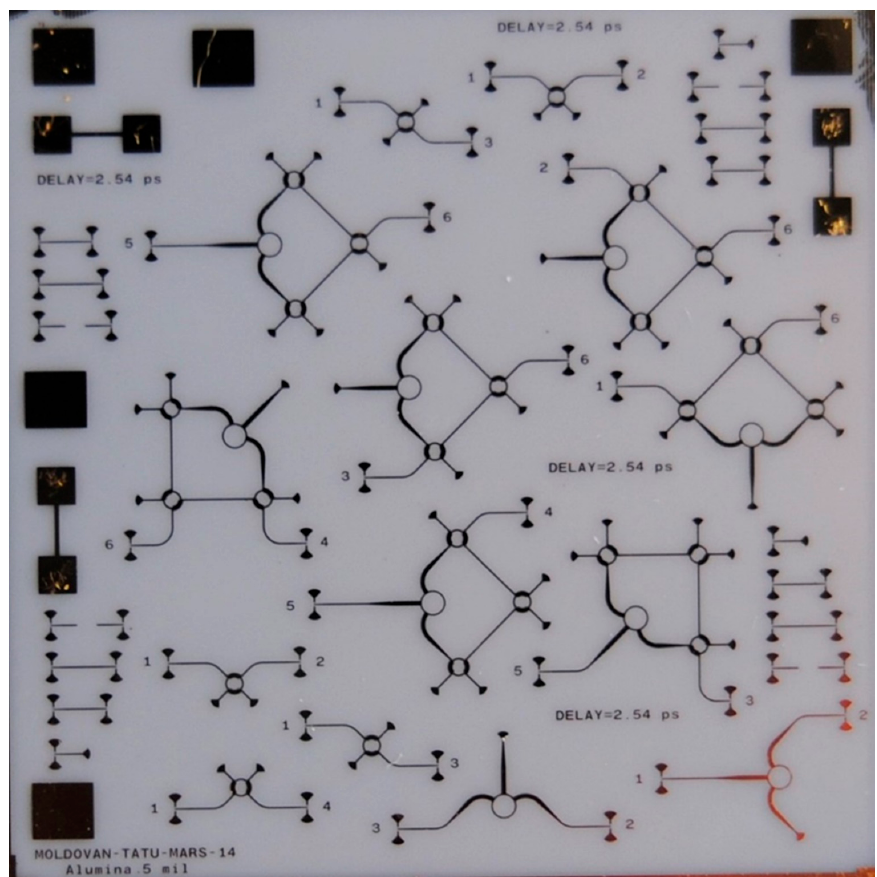
Figure 22. Photo of MHMIC circuits on the ceramic die prepared for full-port S-parameter measurements. Sensors 2020 , 20 , x FOR PEER REVIEW 18 of 44